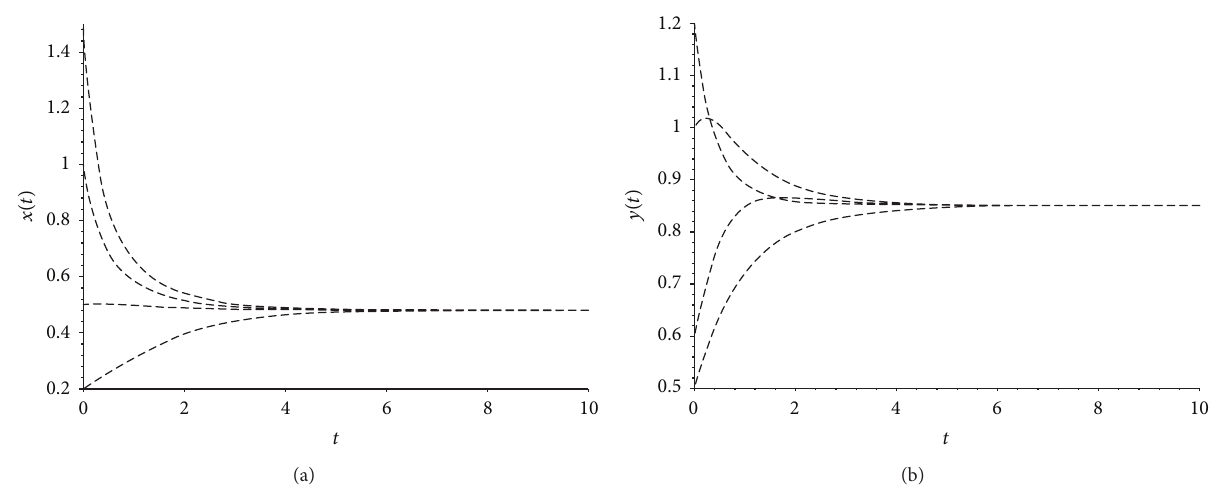
Figure 1: Dynamics behaviors of system (7). Here, we take the initial conditions (𝑥 1 (0),𝑥 2 (0)) = (0.5, 1.2), (1.5, 1), (0.2, 0.5) and (1, 0.6) ,